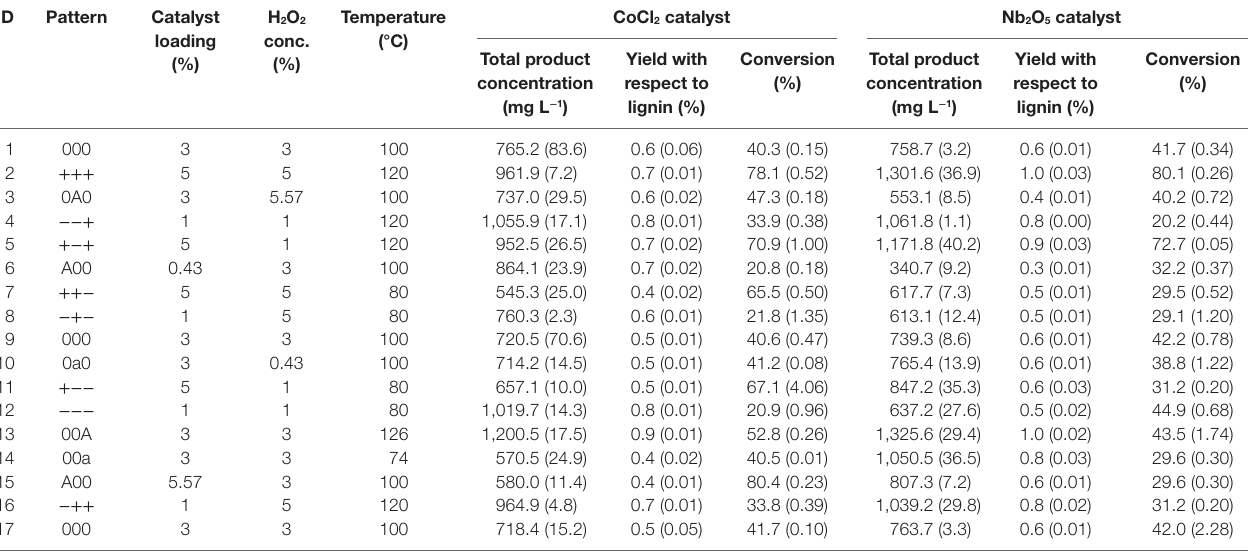
Table 2 | Experimental conditions and corresponding product concentrations, conversion, and yield. a